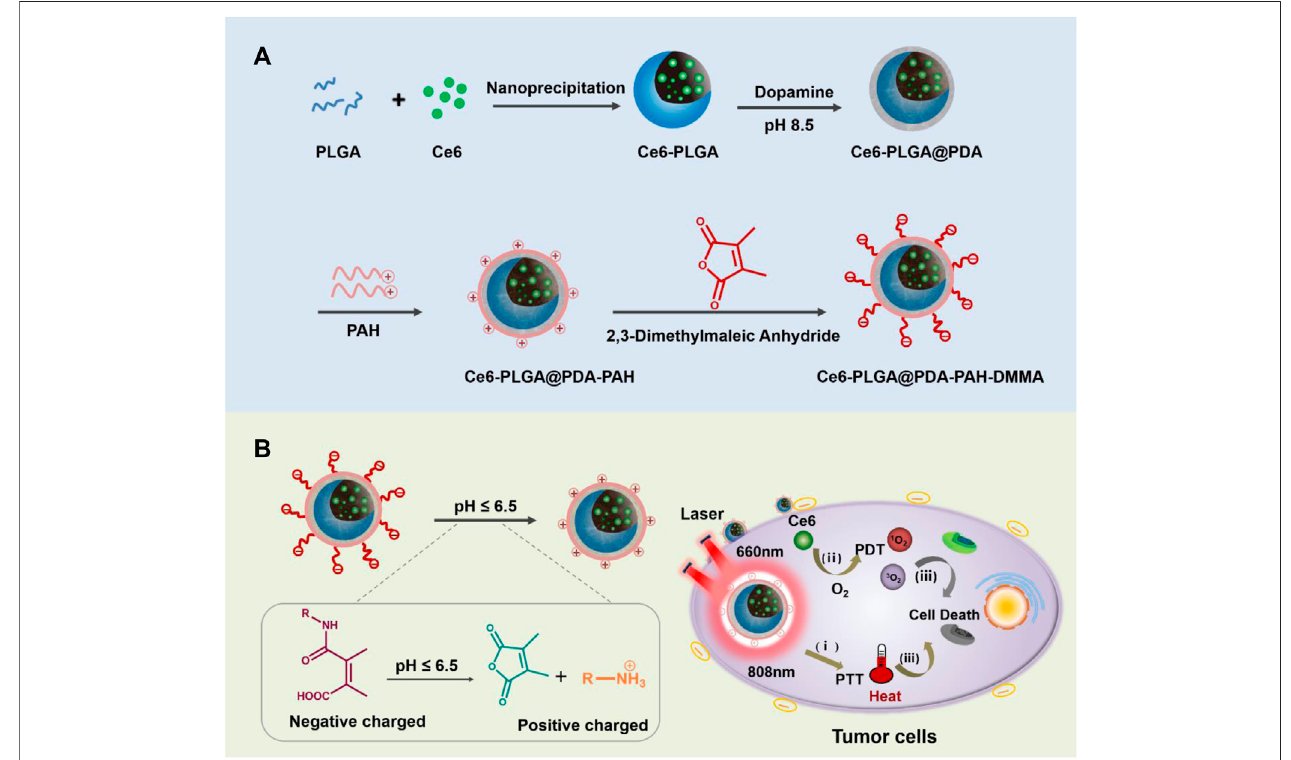
FIGURE 1 | (A) Schematic diagram of the preparation progress of Ce6-PLGA@PDA-PAH-DMMA NPs. (B) Ce6-PLGA@PDA-PAH-DMMA NPs applied to PTT/ PDT synergistic breast cancer